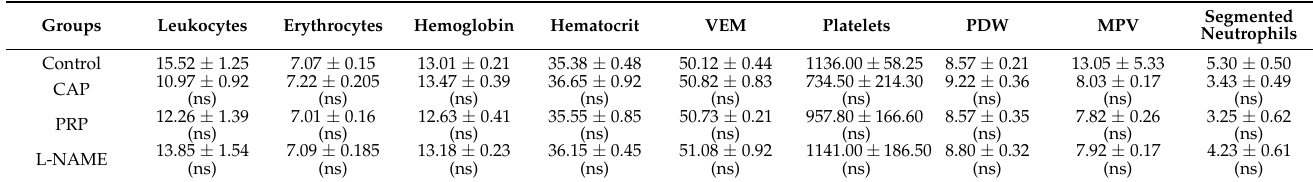
Table 3. Hematological parameters of the groups